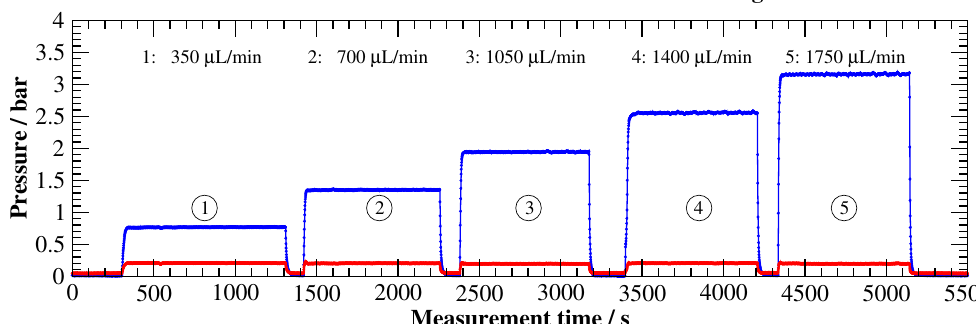
Figure 13. Determination of the dynamic viscosity for a solution by measuring the pressure loss over a capillary tube at different flow rates. The blue curve shows the pressure at the inlet of the capillary tube (upstream pressure) and the red curve, the pressure at the outlet of the capillary tube (down- stream pressure). The pressure at the outlet side is set to 0.20 bar by means of a needle valve regardless of the selected flow rate. This value was also one of the calibration points for the pressure